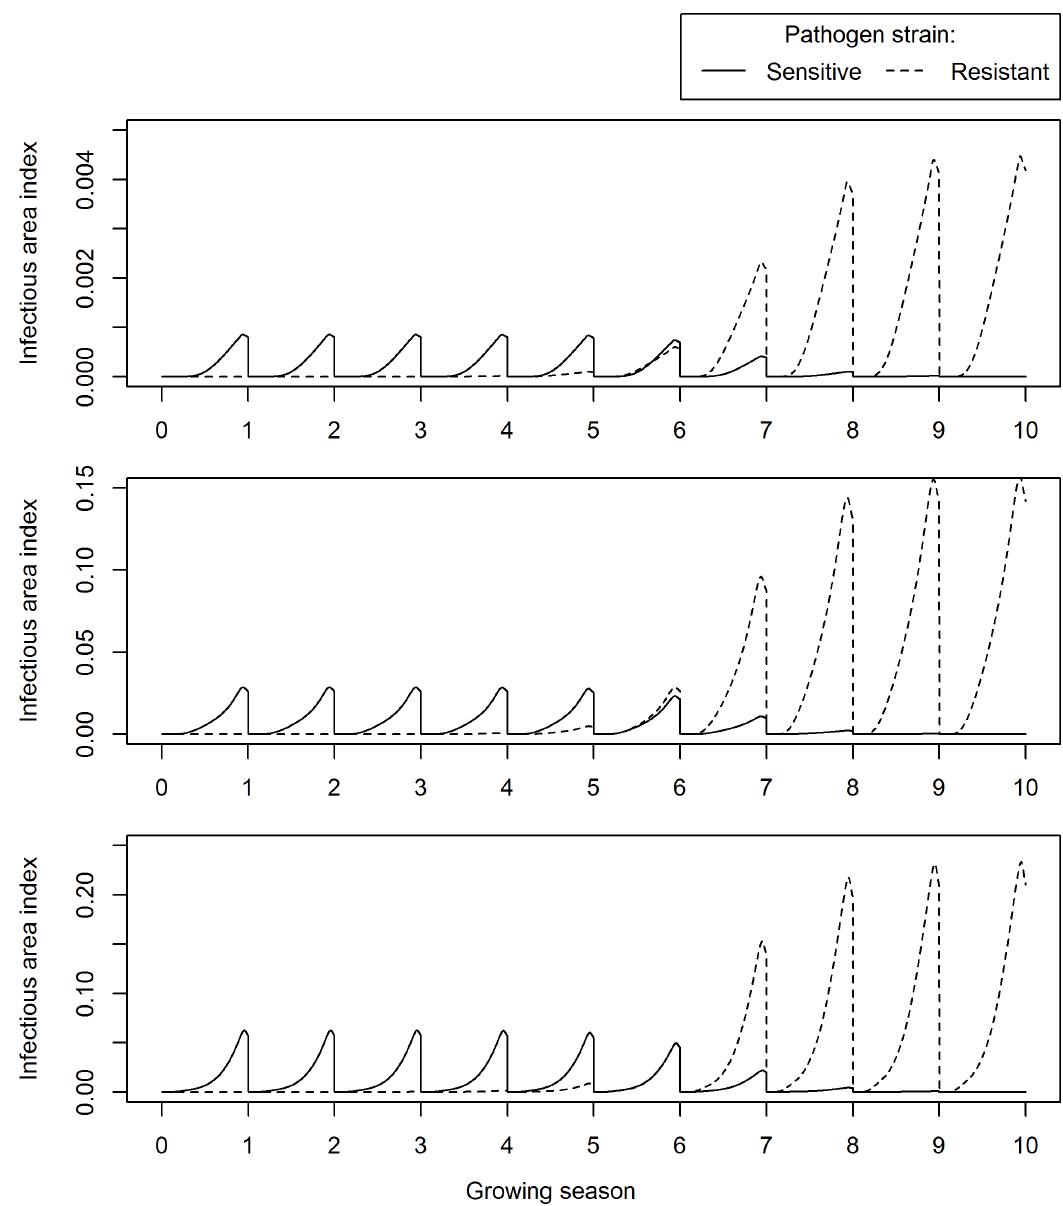
Fig 6. Time course of the sensitive and resistant pathogen strain for a T1 foliar treatment. The simulation was run for a low fungicide breakdown rate and a constant seed treatment uptake model. Blue and red lines indicate fungicide- sensitive and fungicide-resistant area index, respectively. Top panel: leaf layer 11. Middle panel: leaf layer 5. Bottom panel: leaf layer 1. A T1 spray was applied at 20 mg/m 2 and the simulation was run for 10 growing